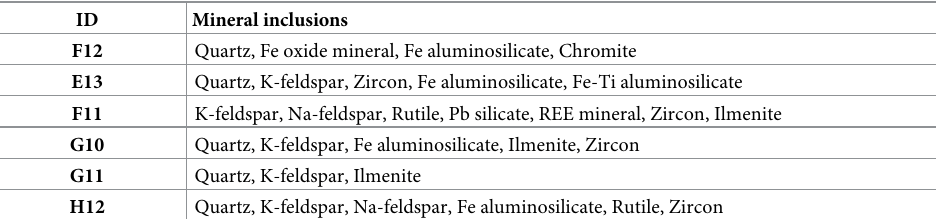
Table 4. Summary of mineral inclusions